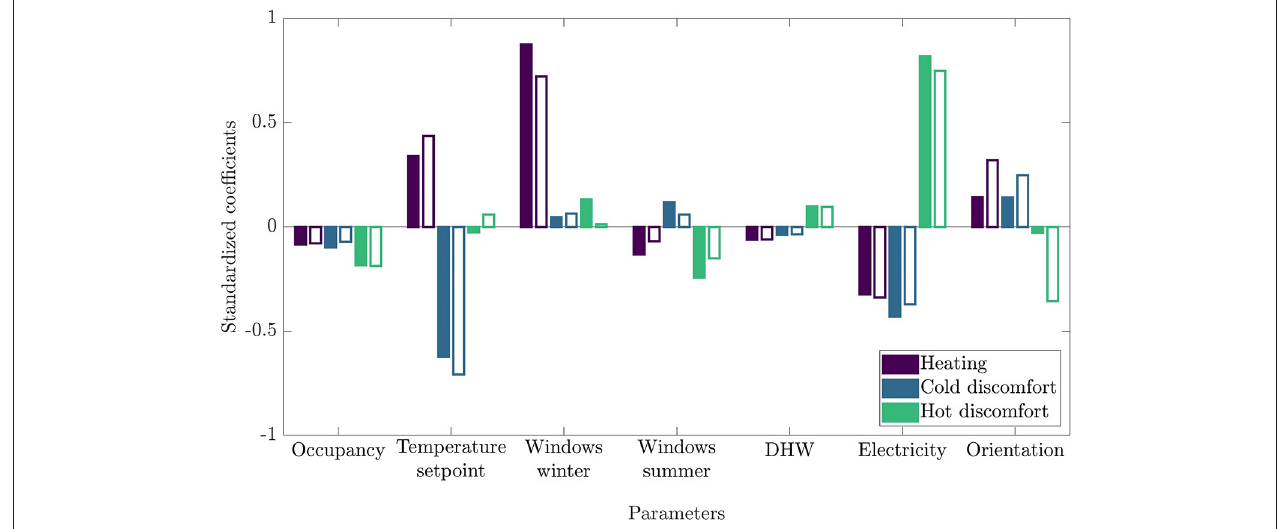
FIGURE 12 | Standardized coefficients for each variables in the heating, energy and discomfort regression models for different WWR: filled = 13%, blank =